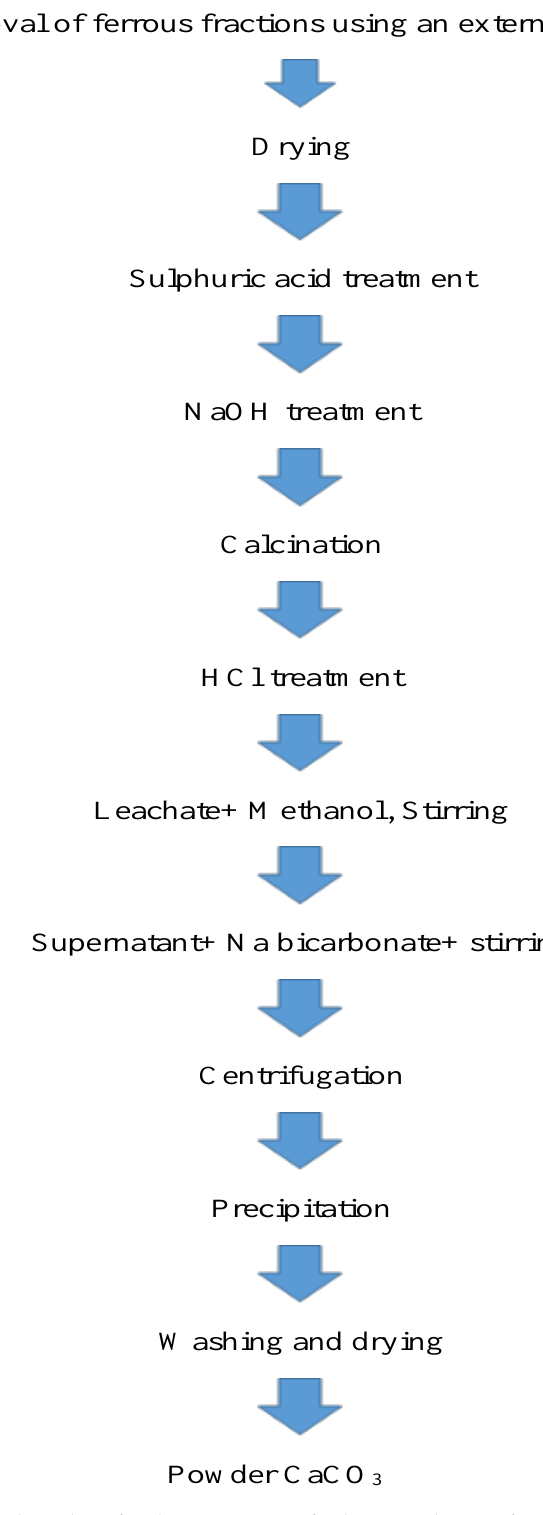
Figure 1. Flow chart for the separation of calcium carbonate from incense stick ash.